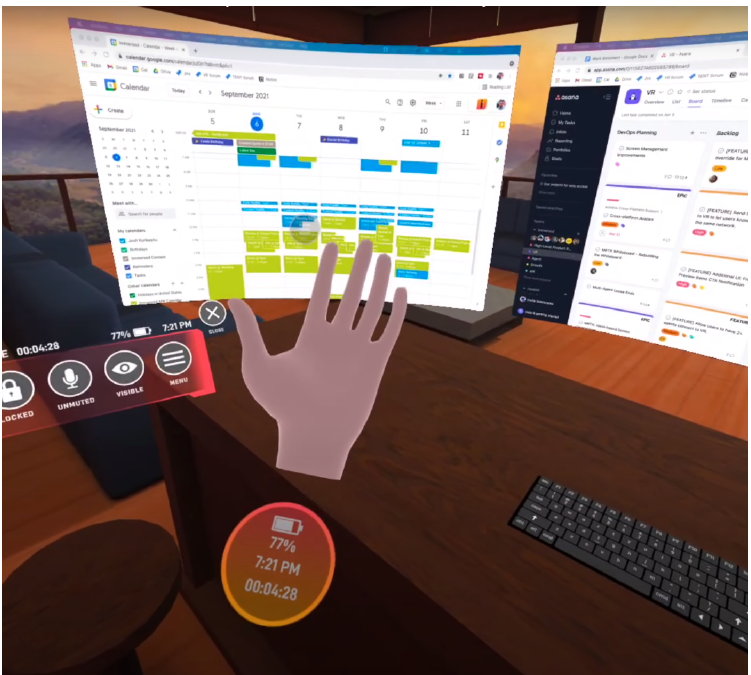
Figure 3. Different screens and menus in the immersed virtual reality. A small menu on the wrist shows the time and charge, and the same information is also shown in the menu on the left side of the picture. This additional information is useful for using the system, but has no direct role in the work. For this reason, the Information Validity (IV) value is lower in the analysis.